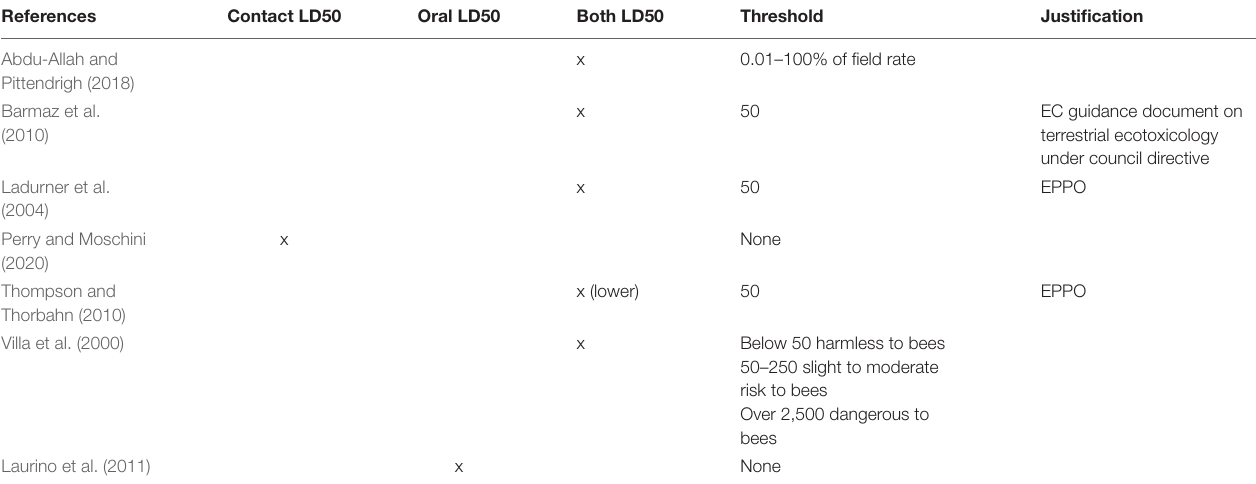
TABLE 2 | A table displaying the contact or oral LD50 value, thresholds associated, and justifications for the thresholds, if provided for HQ calculations from the field application